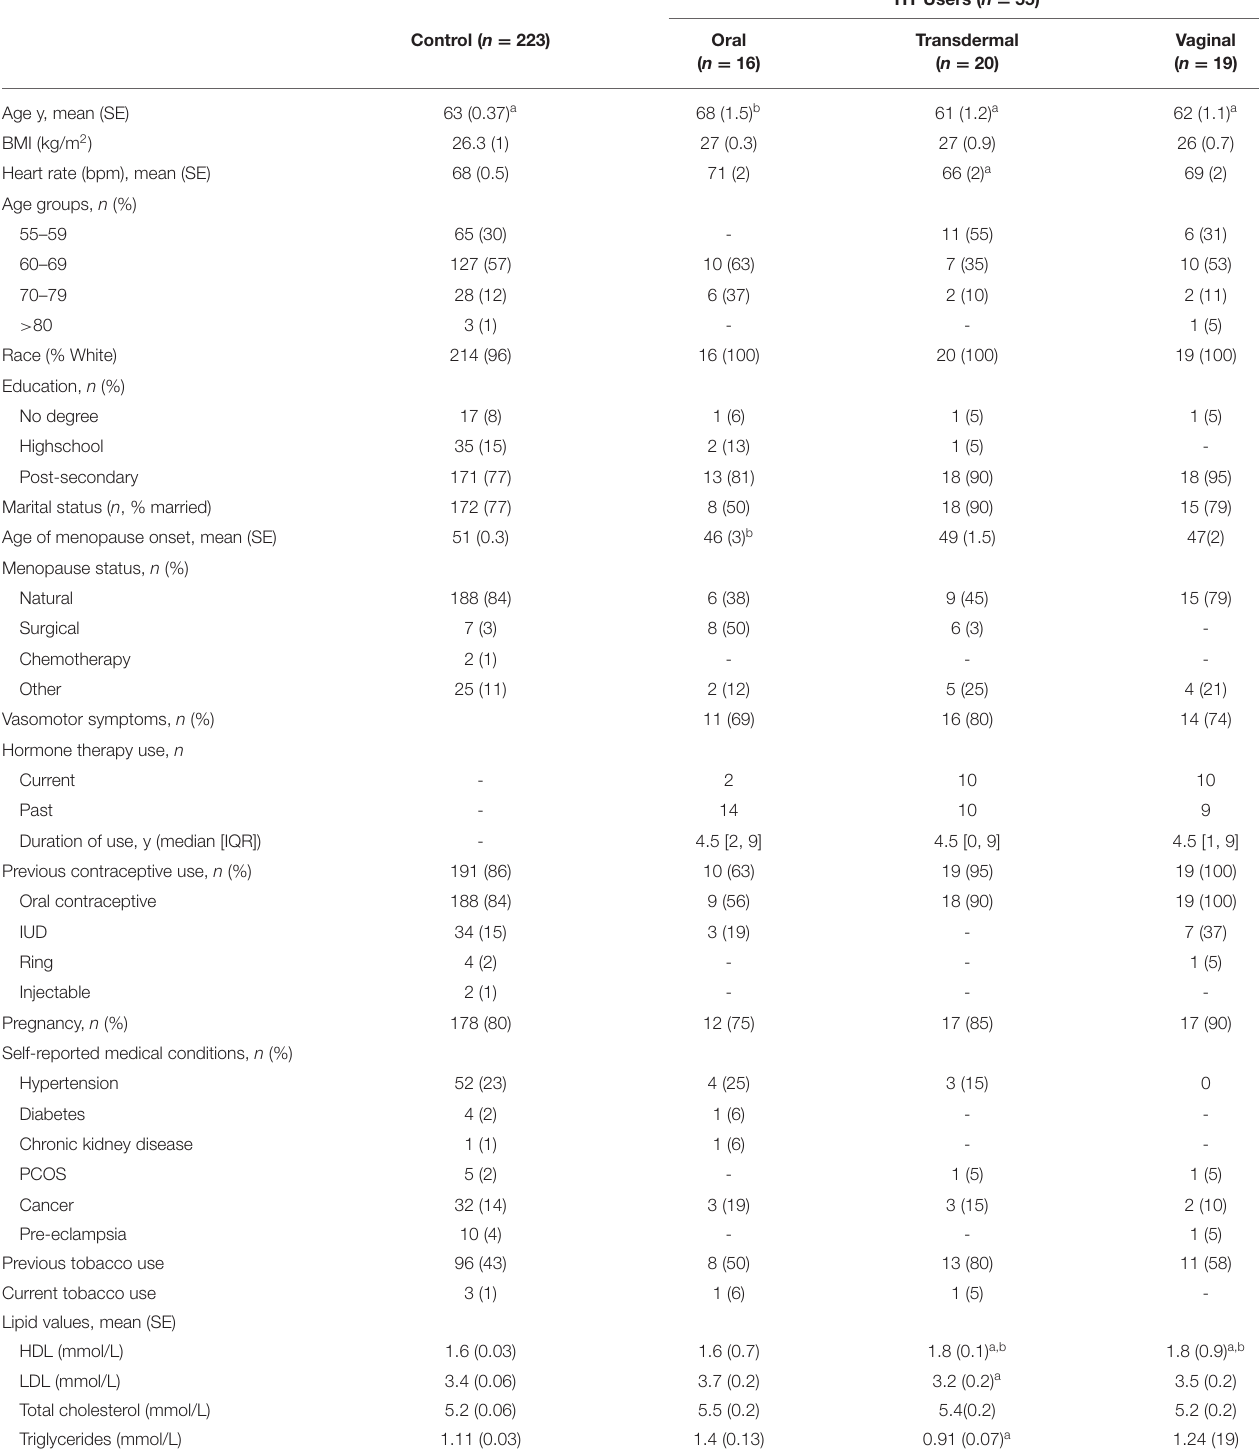
TABLE 1 | Baseline